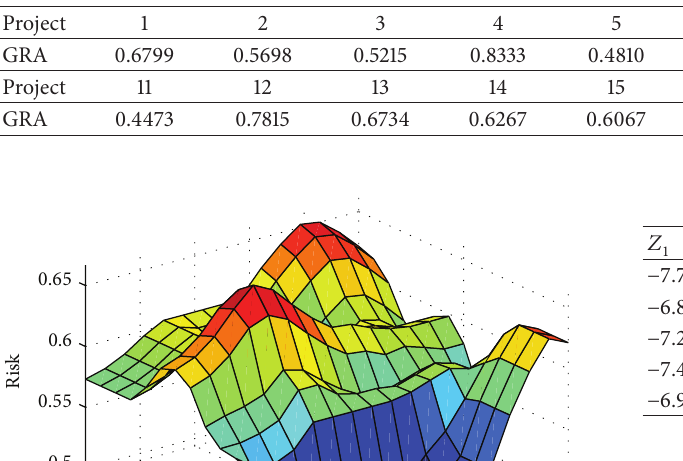
Table 2: The degree of grey relation for the studied projects.